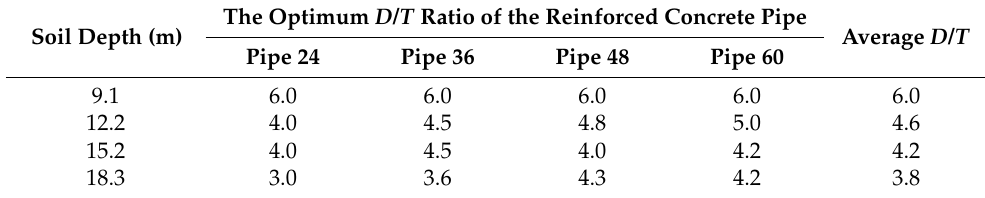
Table 6. Optimum diameter-to-thickness ratio ( D / T ) of the analyzed reinforced concrete pipes. The Optimum D/T Ratio of the Reinforced Concrete Pipe Soil Depth (m)